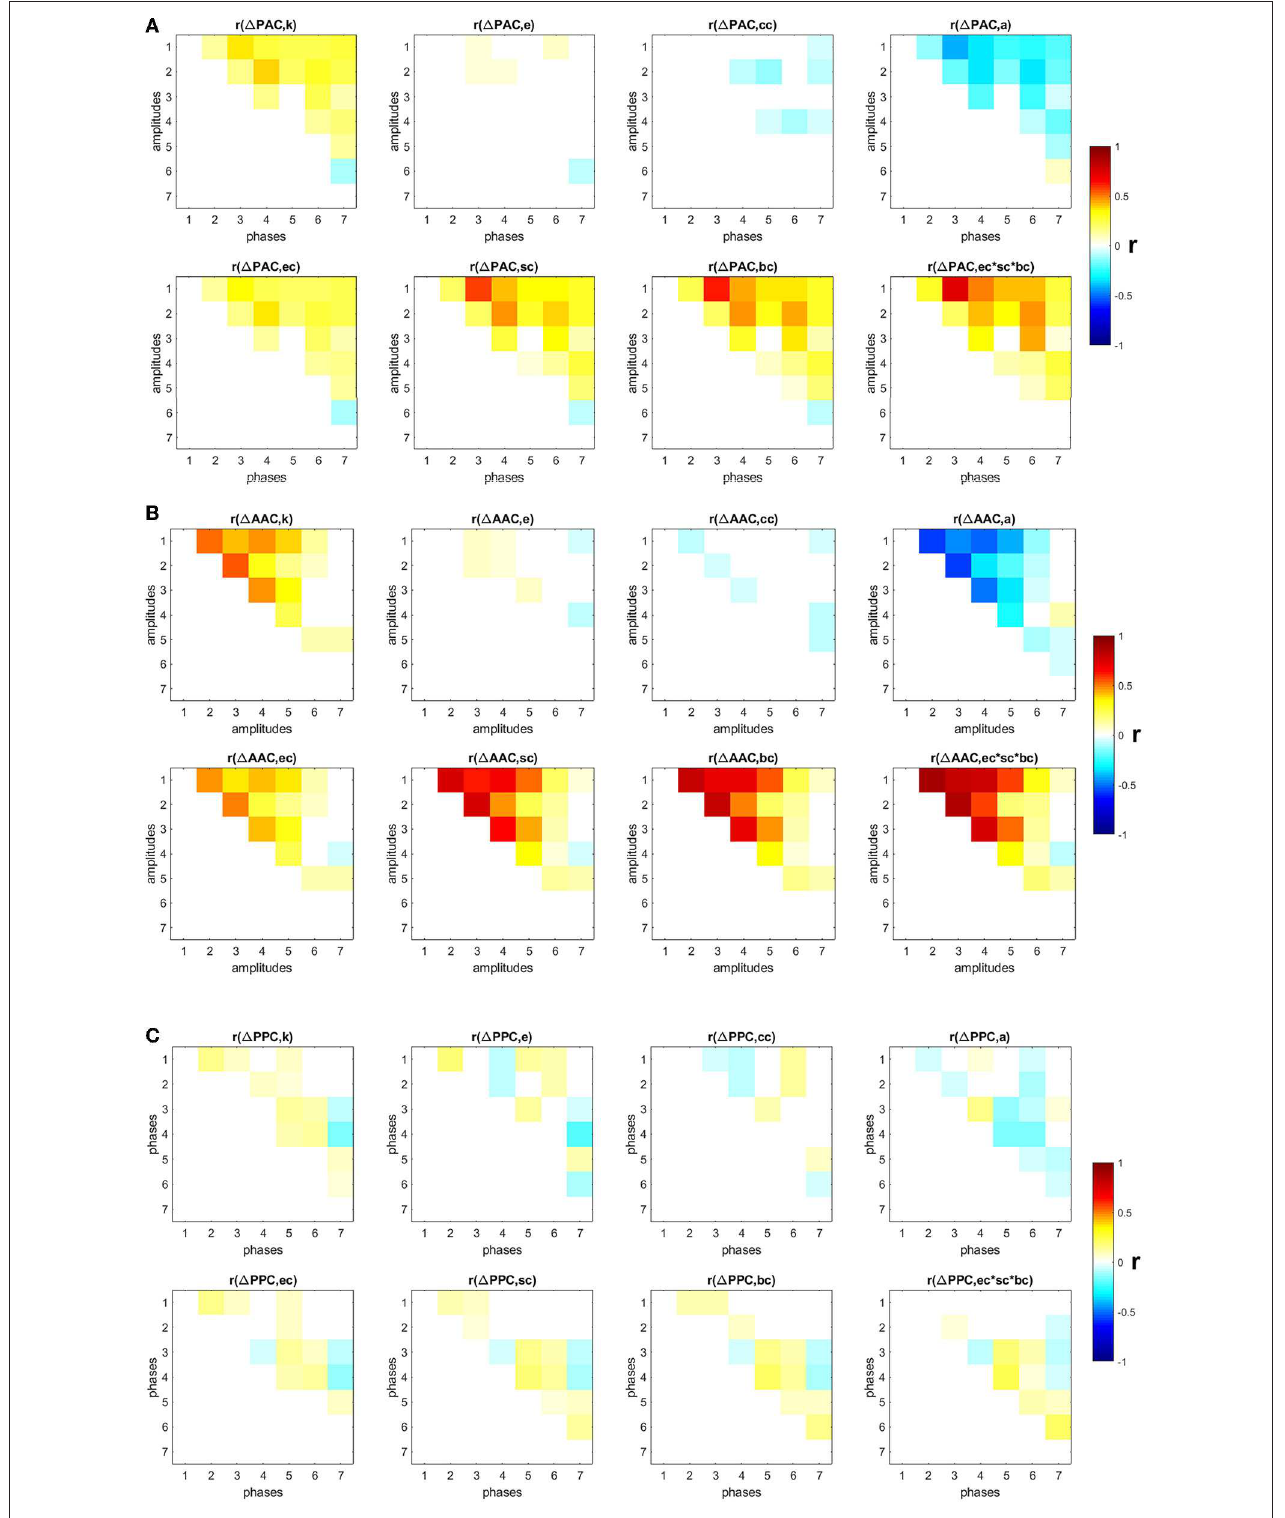
FIGURE 3 | Correlation between changes in CFC and eight topological measures: degree ( k ) , efficiency ( e ) , clustering coefficient ( cc ) , assortativity ( a ) , eigenvector centrality ( ec ) , subgraph centrality ( sc ) , betweenness centrality ( bc ) , product of three centrality measures ( ec × sc × bc ) . Non-significant ( p < 0.05 ) correlation values after correction by false-discovery rate are displayed in white (A) PAC, (B) AAC, (C) PPC.